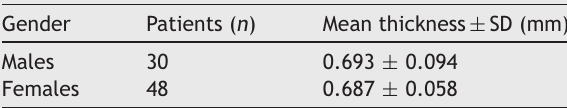
Average thickness of tragal cartilage with regard to